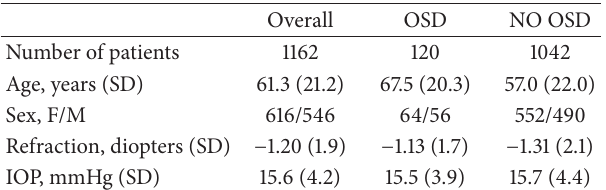
Table 1: Demographic and ophthalmic characteristics of study